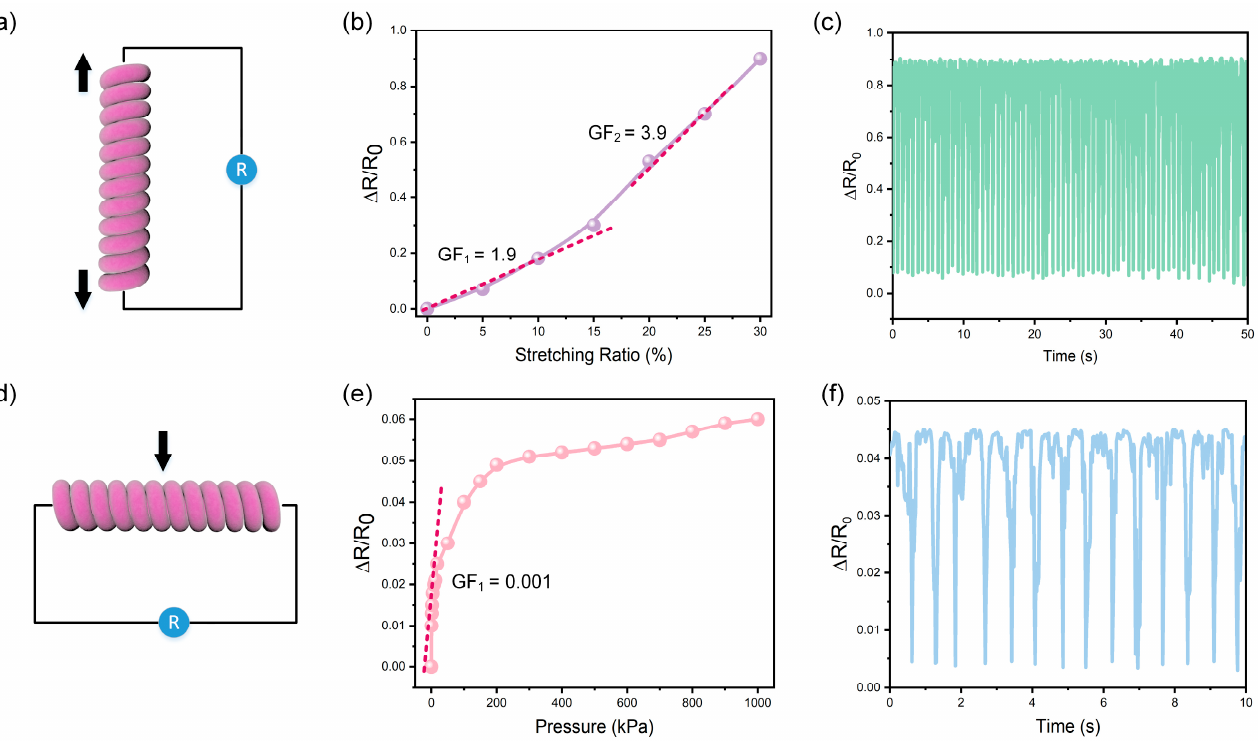
Figure 3. Stretching strain and Pressure perceptive properties. ( a ) Schematic illustration of the working mechanism for the stretching perception; ( b ) The sensitivity of the stretching perception; ( c ) Resistance variation of stretching cycle tests; ( d ) Schematic illustration of the working mechanism for the pressure perception; ( e ) The sensitivity of the pressure perception; ( f ) Resistance variation of pressing cycle tests.